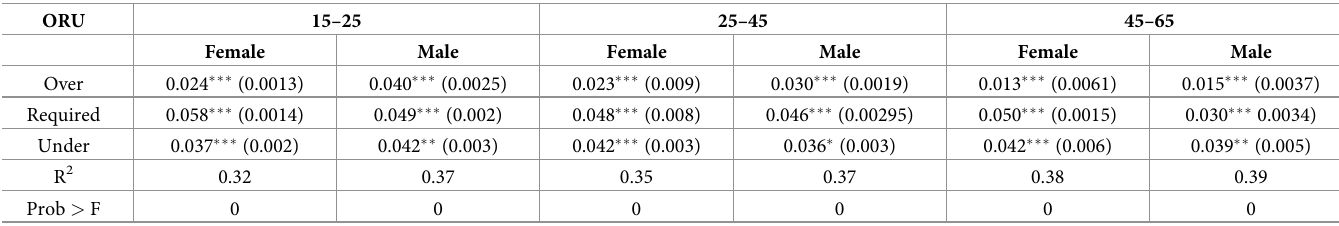
Note: (1) Robust Standard Error clustered by the industry are given in parentheses. (2) This Table only reports the estimates of ORU specifications. The model estimation includes the complete set of variables and a constant term as in Table 5.